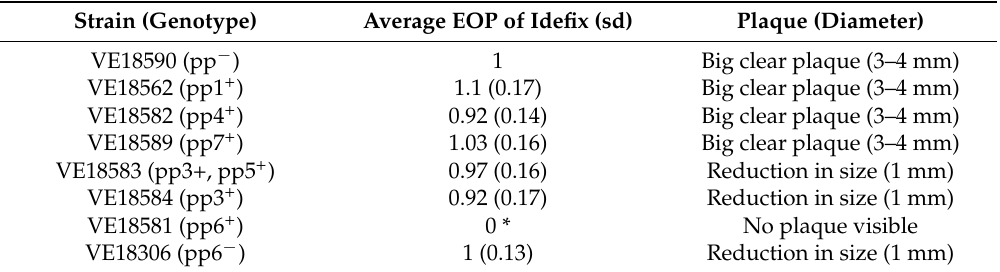
Table 1. Efficiency of plaquing (EOP) of phage Idefix on E. faecalis V583 derivatives deleted from different